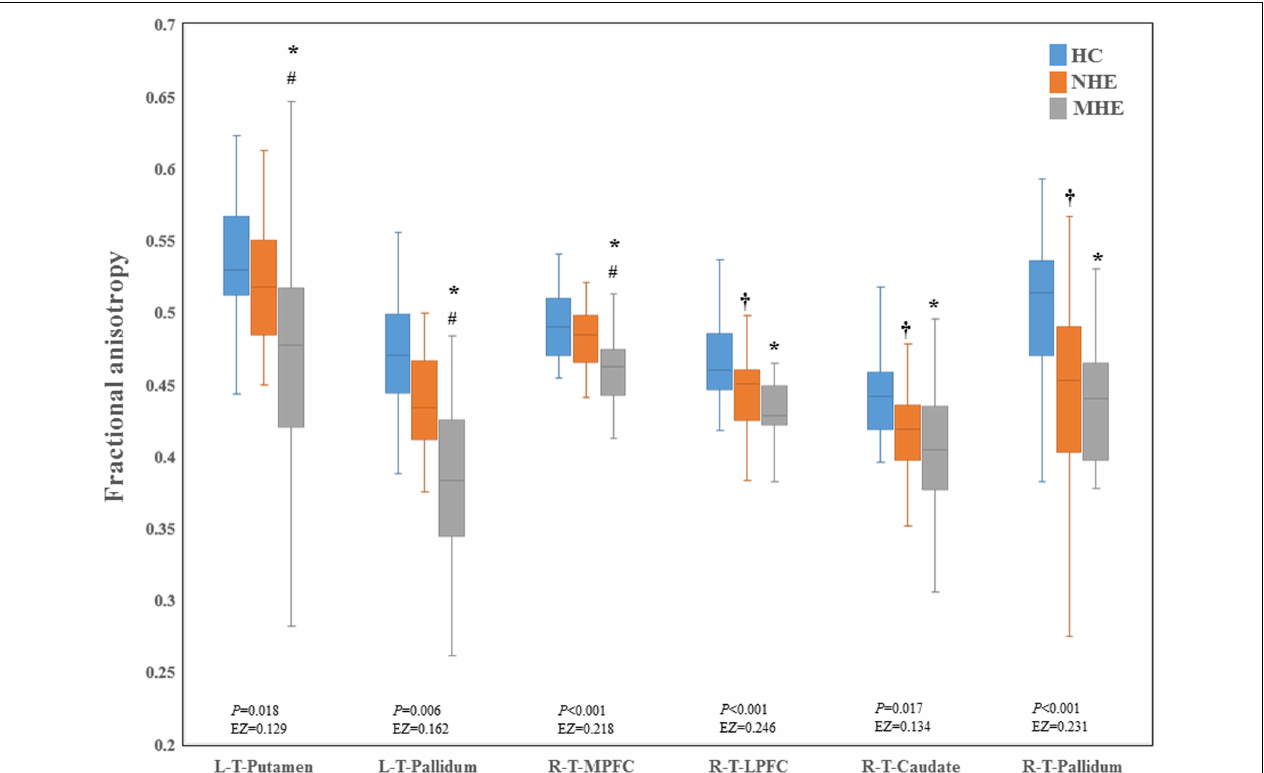
FIGURE 3 | Between-group difference in fractional anisotropy. The false discovery rate (FDR)-corrected P values and the effect size (EZ) are shown. The symbols *, † , and # indicate significant differences in MHE vs. HC, NHE vs. HC, and MHE vs. NHE, respectively. MHE, minimal hepatic encephalopathy; NHE, patients without MHE; HC, healthy control; LPFC, lateral prefrontal cortex; MPFC, medial prefrontal cortex; T, thalamus; L, left; R,